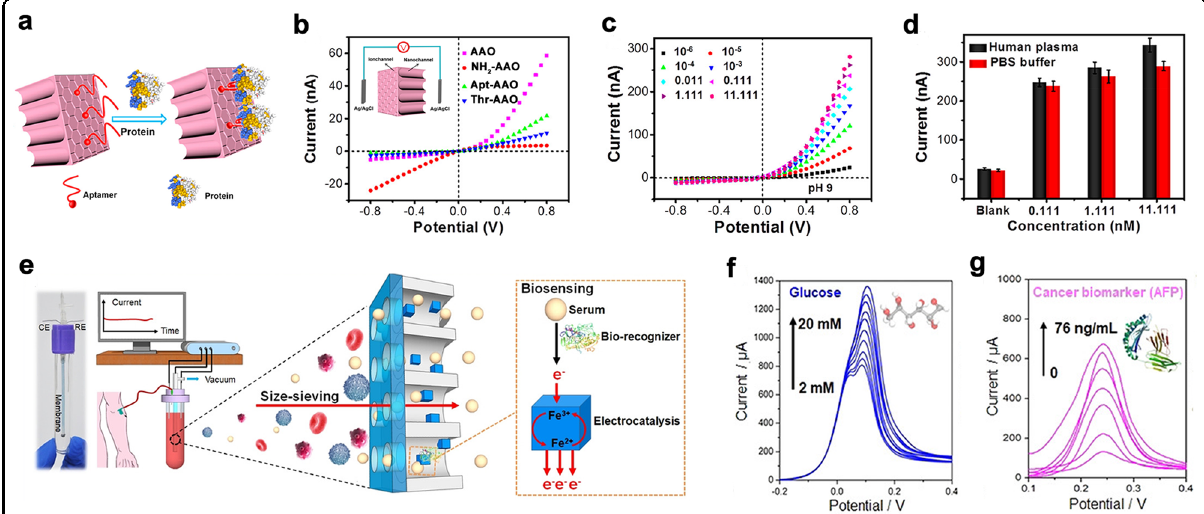
Fig. 9 Hierarchical nanochannel membrane for biosensing. a nanochannel − ion channel hybrid AAO membrane for use in protein sensing. b I ‒ V curves of the membrane in different states. c I ‒ V curves of the aptamer-modi fi ed membrane under different concentrations of thrombin. d Ionic current at + 0.8 V vs. different concentrations of thrombin from buffer solution and human plasma, respectively. Reproduced with permission 87 . Copyright 2019, American Chemical Society. e Hierarchical nanochannel membrane possessing pores for sieving and nanochannels for biosensing. Cyclic voltammetry curves of this membrane for detecting glucose ( f ) and the cancer biomarker α -fetoprotein ( g ). Reproduced with permission 88